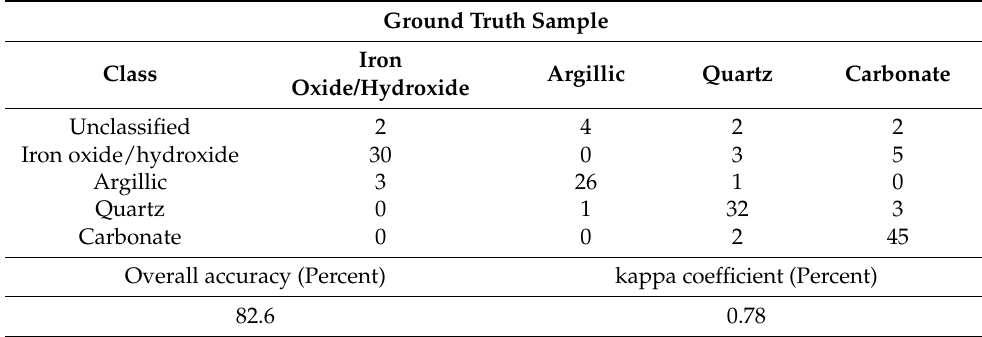
Table 6. The accuracy assessment of the SPCA mapping method for hydrothermal alteration minerals based on ASTER data.